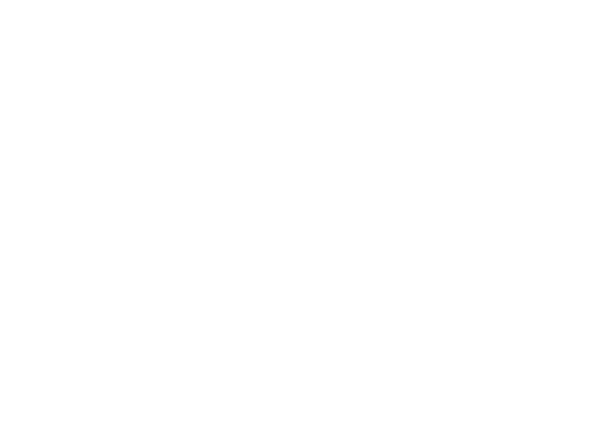
Figure 11. Origin point of the LiDAR coordinate system and the axis of rotation of the rotating base.